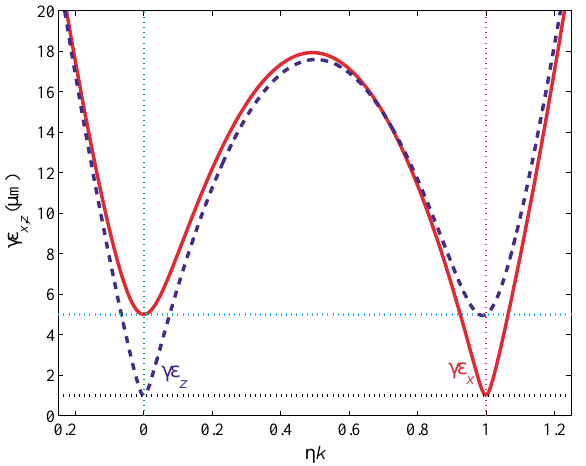
FIG. 5. (Color) Normalized projected emittances (solid/red: g´ x , dashed/blue: g´ z ) as a function of h k . Both emittances increase, except at h k (cid:1) 0 and h k (cid:1) 1 , due to large x - z coupling in the beam. The emittances of the principal planes are evident only at these two